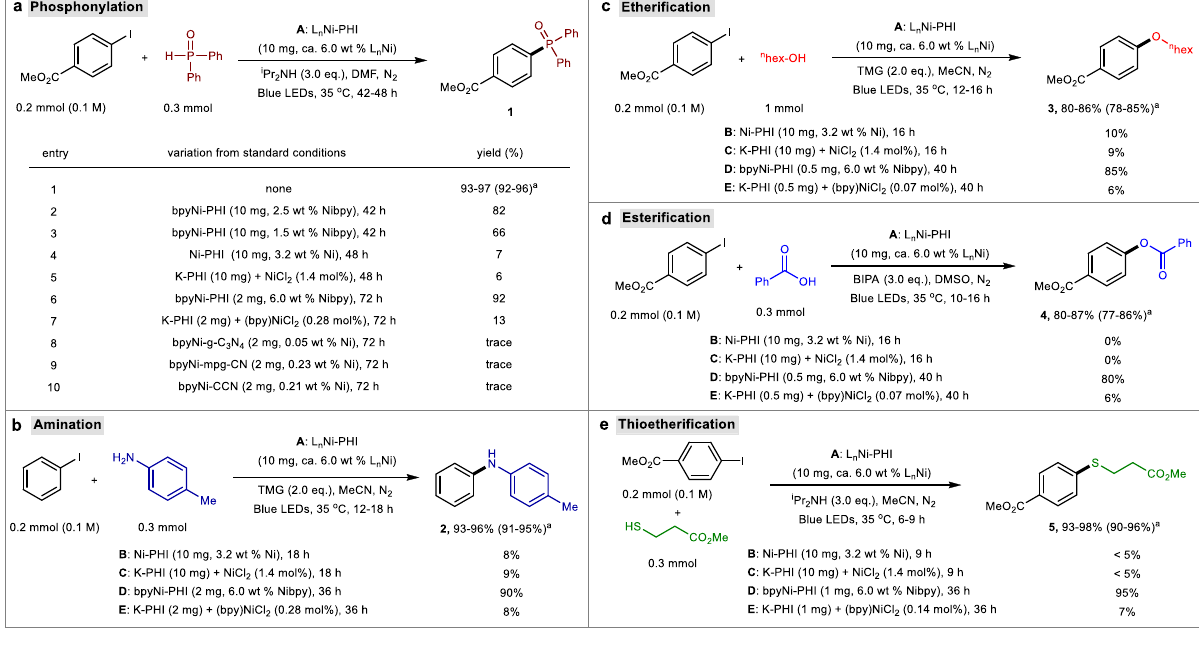
1 H-NMR analysis using 1,3,5-trimethoxybenzene as an internal standard. a Phosphonylation. a Isolated yield in parenthesis. b Amination. c Etheri fi cation. d Esteri fi cation. e Thioetheri fi